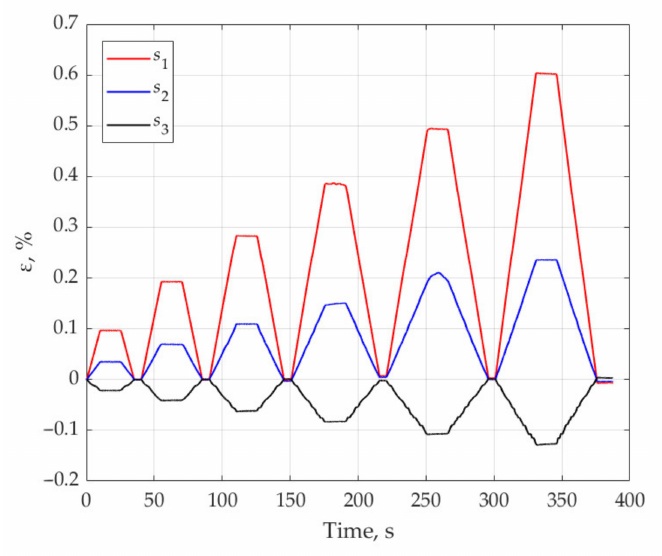
Figure 9. The strain values measured by the sensors s 1 , s 2 , s 3 when the sample was under tension in direction 1.